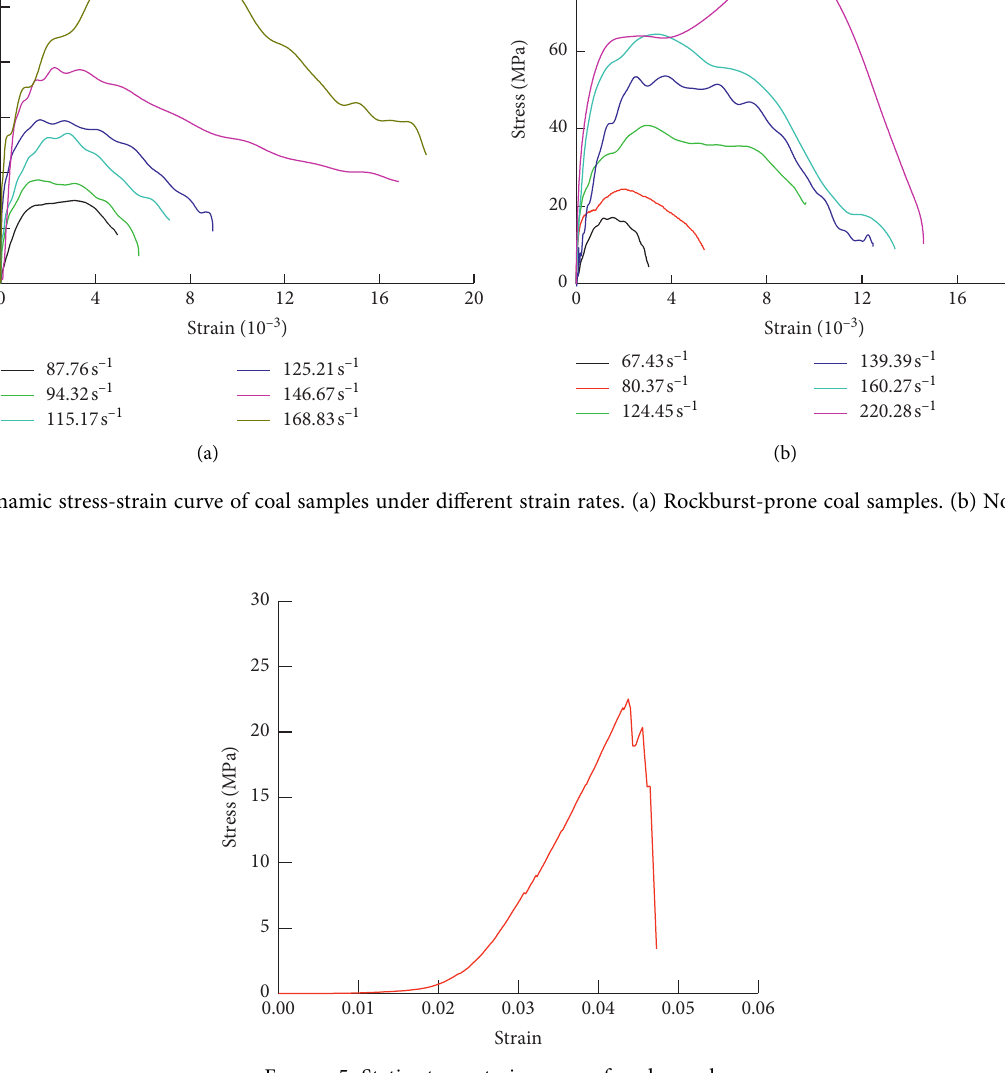
Figure 5: Static stress-strain curve of coal